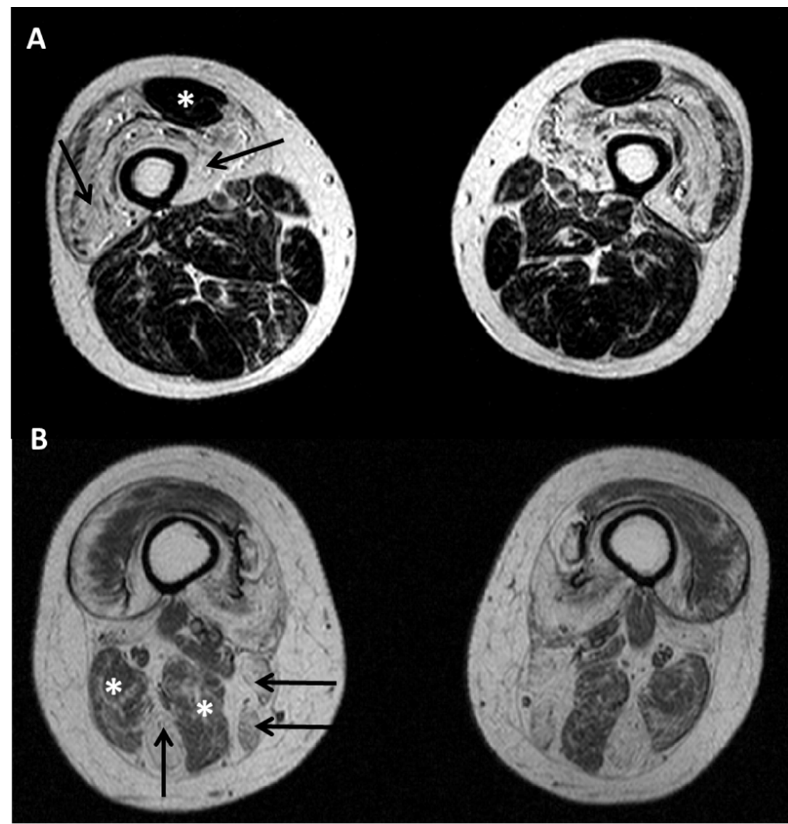
Figure 4. T1 weighted muscle MRI at thigh level in LMNA ( A ) and DES ( B ) mutated patients. ( A ) Marked fatty infiltration of the vasti (arrows) with sparing of the rectus femoris (asterisk) and of posterior compartment. ( B ) Marked fatty changes in semitendinosus, sartorius and gracilis (arrows) with relative sparing of long head of biceps femoris and semimembranosus (asterisks).